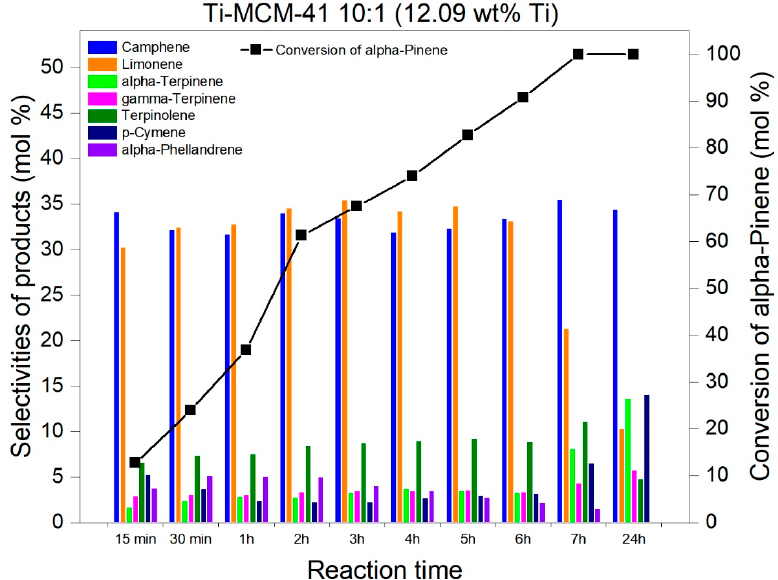
Figure 12. The influence of the reaction time on the conversion of α -pinene and on the product selectivity (temperature 160 °C, 7.5 wt% Ti-MCM-41 10:1 catalyst content relative to α -pinene).